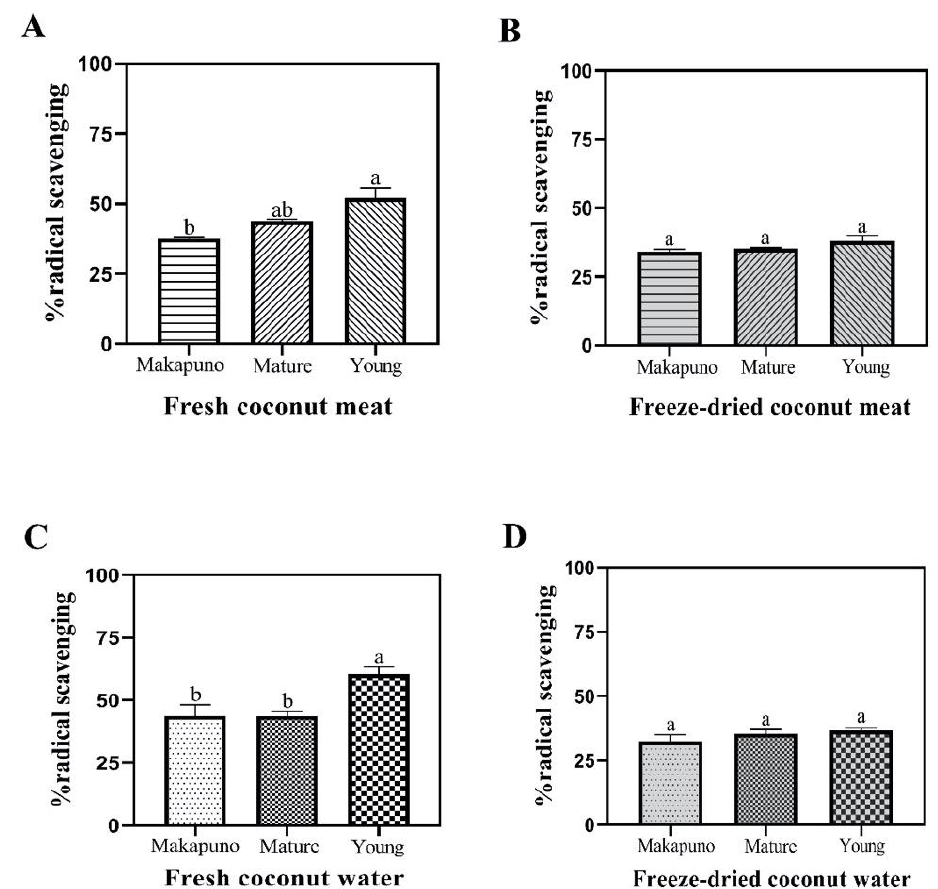
Figure 6. The % DPPH radical scavenging activity in coconut samples. % DPPH radical scavenging activity in coconut meats in fresh ( A ) and freeze-dried ( B ) samples. % DPPH radical scavenging activity in coconut water in fresh ( C ) and freeze-dried ( D ) samples. All experiments were performed in biological triplicate. Data are expressed as mean ± SE (n = 3, p < 0.05) for all tested. Different letters indicate mean values significantly